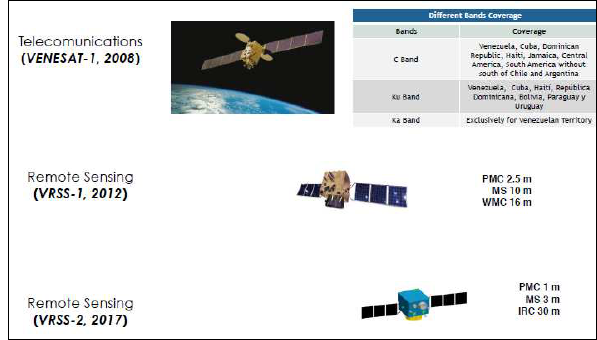
Figure N° 1: Venezuelan space program. Source: M. Imbert